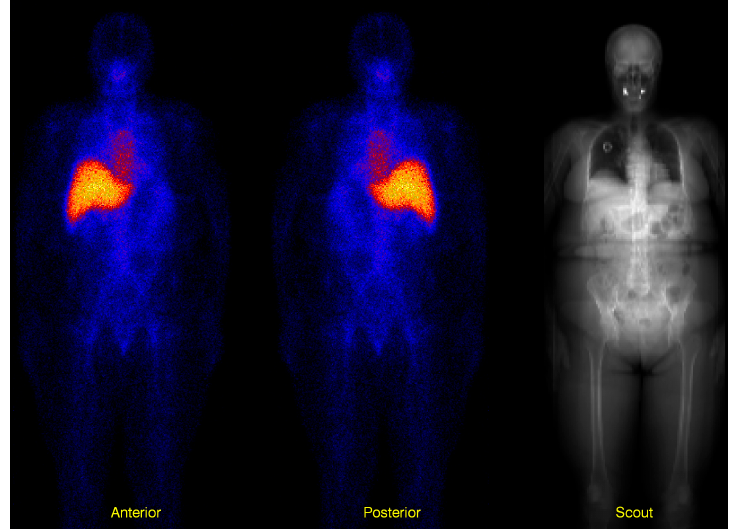
Figure 5. Three images showing anterior and posterior whole-body images. Before applying the geometric-mean on a pixel-by-pixel level, the posterior image is mirrored. The image to the right is the scout image whose intensity describes the amount of photon attenuation in the patient. Bright areas indicate a large probability for photon attenuation. This image is acquired with the X-ray unit, and the values are scaled to represent the attenuation factor for the relevant photon energy. The spatial misregistration between the scout image and the two planar images is accounted for by an image registration procedure, tailored for whole-body images, as described further down in the text.